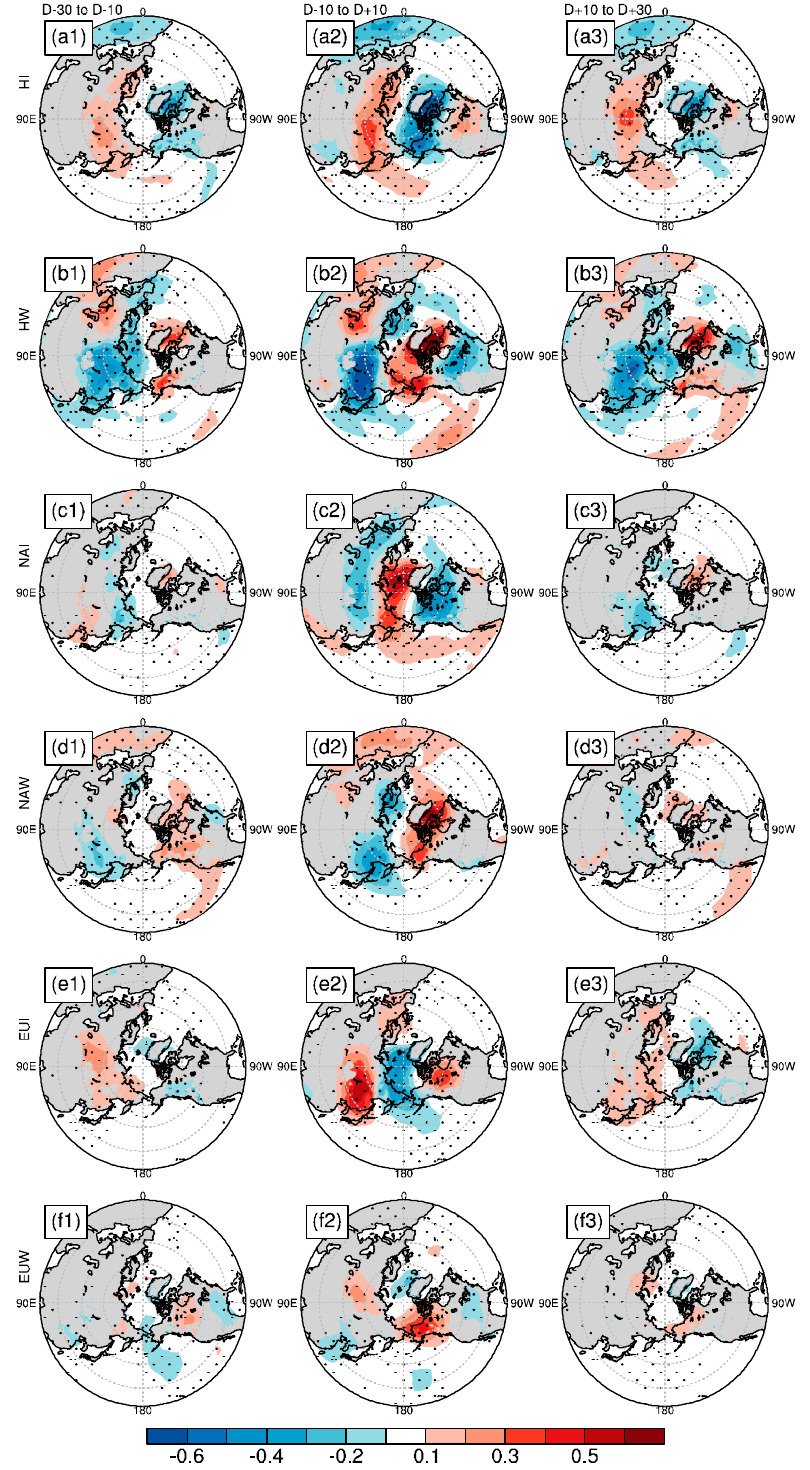
Figure 6. Composited leading/lagging evolutions of the standardized 850 hPa temperature anomalies (shading) from 20 to 90°N during three stages of the six stratospheric Arctic vortex weather regimes. ( a1 – f3 ) The clusters 1-6 are printed as HI, HW, NAI, NAW, EUI, and EUW regimes, respectively. The first column displays the average for days -30 to -10, the second column displays the average for days -10 to 10, and the third column displays the average for days 10 to 30. The dotted area indicates the composited anomalies significant at the 99% confidence level.